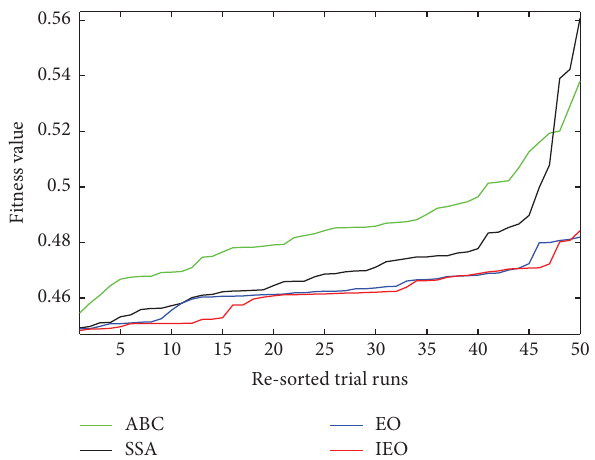
Figure 17: Te ftness values of 50 trial runs in increasing arrangement for the IEEE 85-bus system.